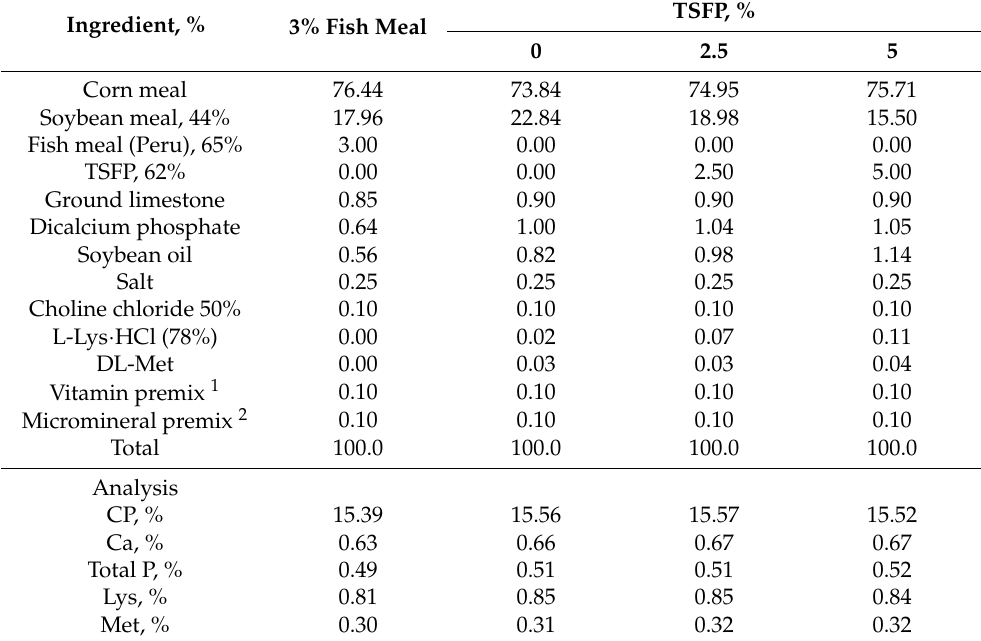
Table 1. Composition of experiment diets (as-fed